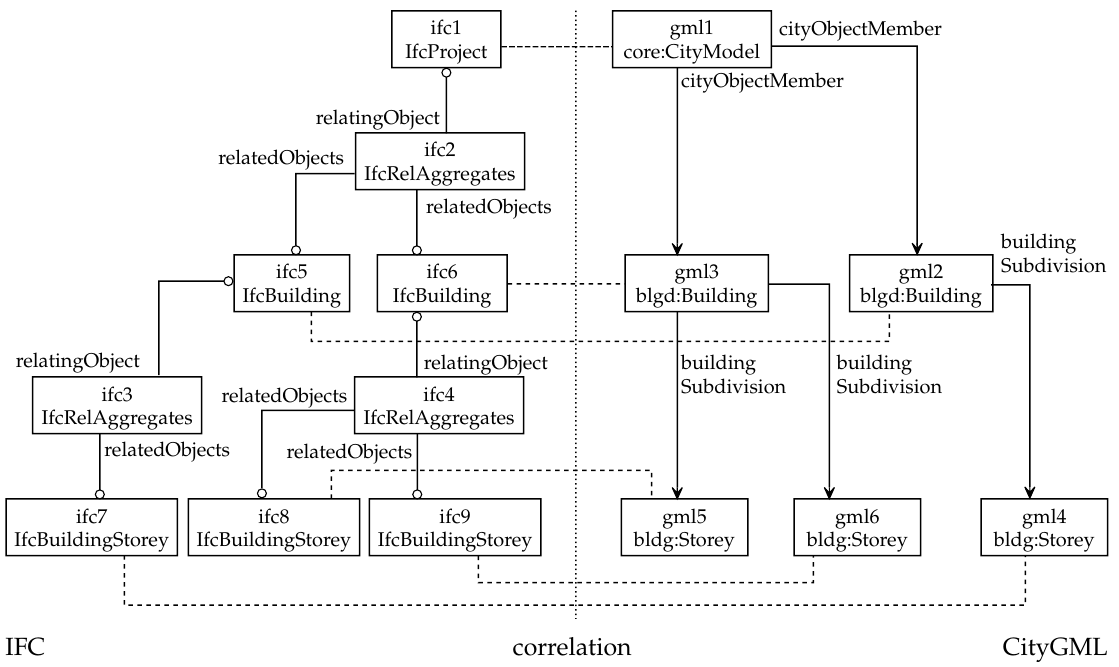
Figure 3. Triple graph consisting of an IFC (Industry Foundation Classes) graph (left, edges with circle end marks), a CityGML graph (right, edges with arrow and marks), and a correlation graph (dashed